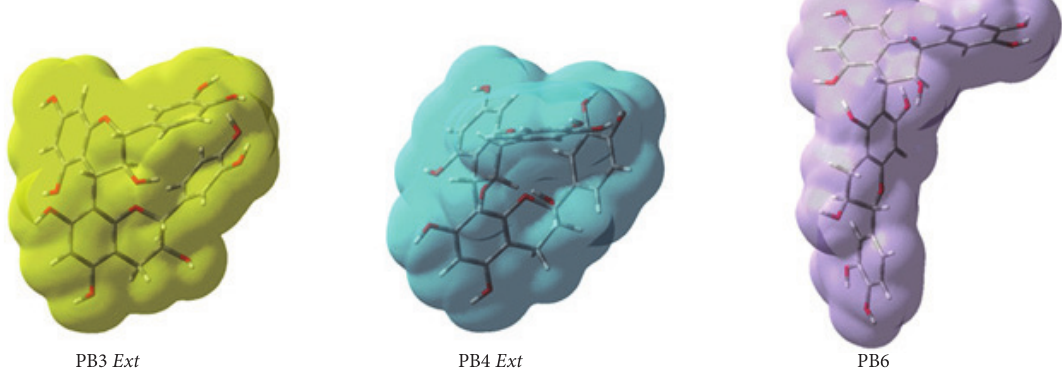
Figure 3: Molecular surface area of the PB3 Ext , PB4 Ext , and PB6 procyanidin dimers, determined under simulation of an aqueous medium (SMD model) using the M05-2X/6- 31 G ∗∗ DFT method. Ext : extended conformation.